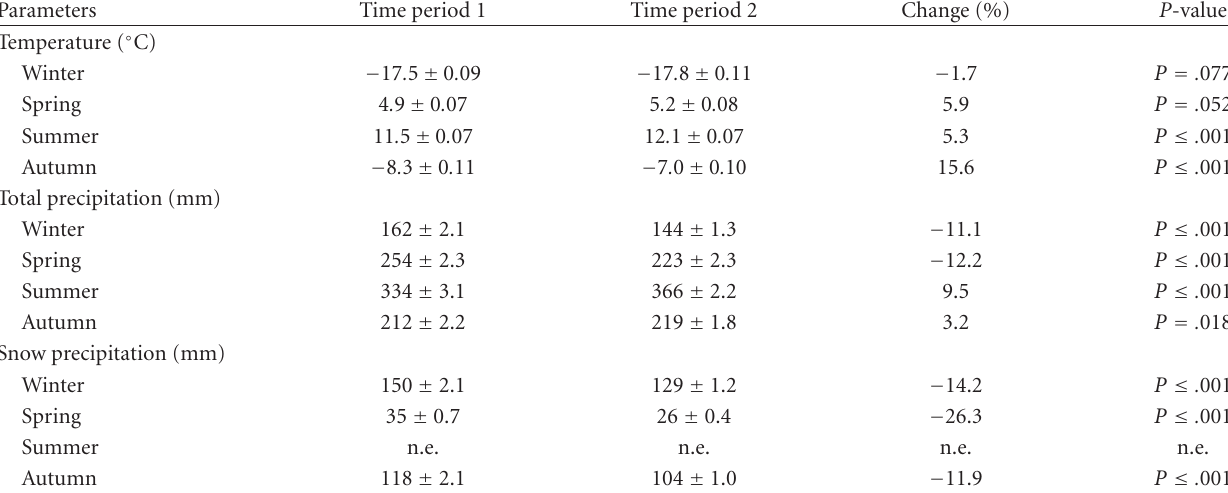
Table 2: Comparison of seasonal temperature, precipitation, and cumulative degree days during the two periods studied. Note: n.e. = not